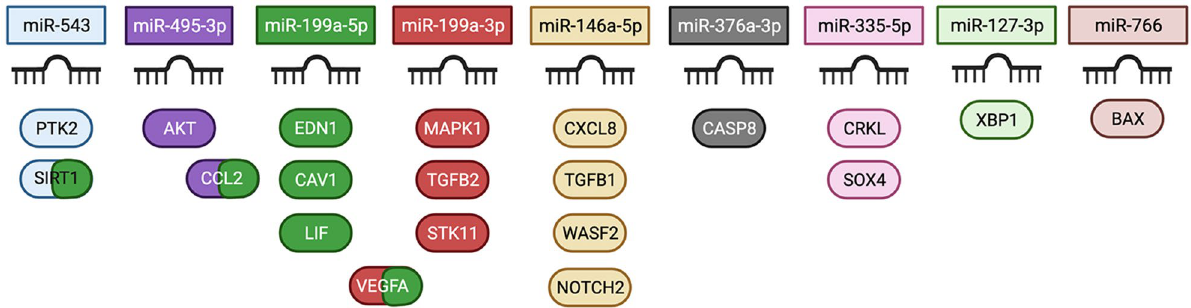
Figure 4. Target genes of differentially expressed genes in CAD patients exposed to high levels of PM 2.5 . Functional miRNA targets associated to both Cardiovascular System and Immune System are shown. Different colors are used to indicate the targets that are regulated by each miRNA. From all genes identified in miRTarBase as targets of microRNAs listed in Table 2, only those with functioonal support were selected to perform the enrichment analysis. Image created with